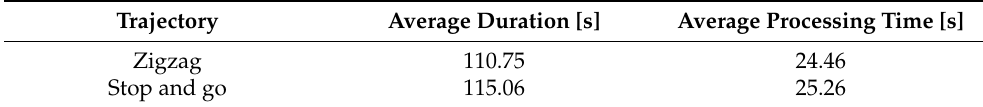
Table 4. Duration and processing time of calibration